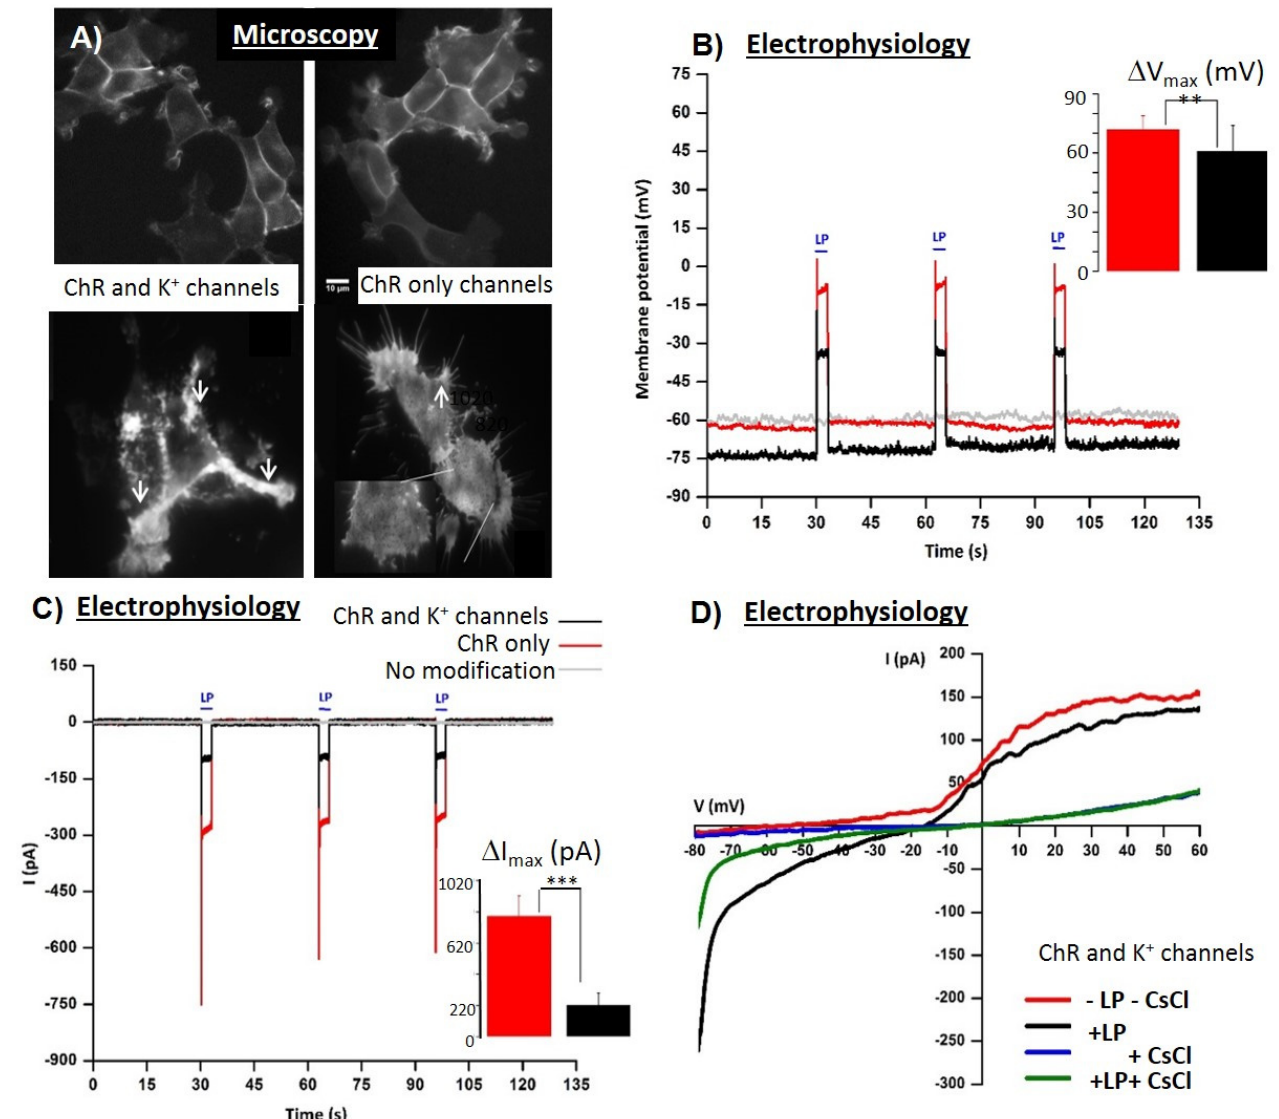
Figure 1. Complementary characterization of the functional expression of genetically encoded ion channels (the ChR2 and ROMK1 channels). Microscopy ( A ): different levels of ChR2-YFP expression can be quantified using fluorescence imaging (fluorescence images, scale bar 10 µ m) as well as their membrane distribution using Total internal Fluorescence Microscopy (lower panel scale bar 1 µ m). Electrophysiology : ( B ) Current clamp data reveal the (resting) membrane potential values (V m ) and their changes upon illumination as a function of channel repertoire; inset membrane potential values changes ( ∆ V max = V max (pulse) − V m ) upon illumination—enabling comparison between light-induced depolarization changes (significance level ** p < 0.01, n =5) for ChR-only ex- pression and ChR and K + channels, respectively. ( C ) The Voltage clamp data reveal transmembrane currents (I) upon illumination and enable quantification of functional channel density. Inset, the amplitude ( Δ I max = I 0 − I max (pulse)) of the current elicited by the first LP is significantly (*** p < 0.001, n = 5) higher for cells expressing ChR only, corresponding to the functional ChR2 channels opening. For cells with a more complex channel repertoire (e.g., cells expressing both ChR and K + channels), separating the individual transmembrane current components require specific channel